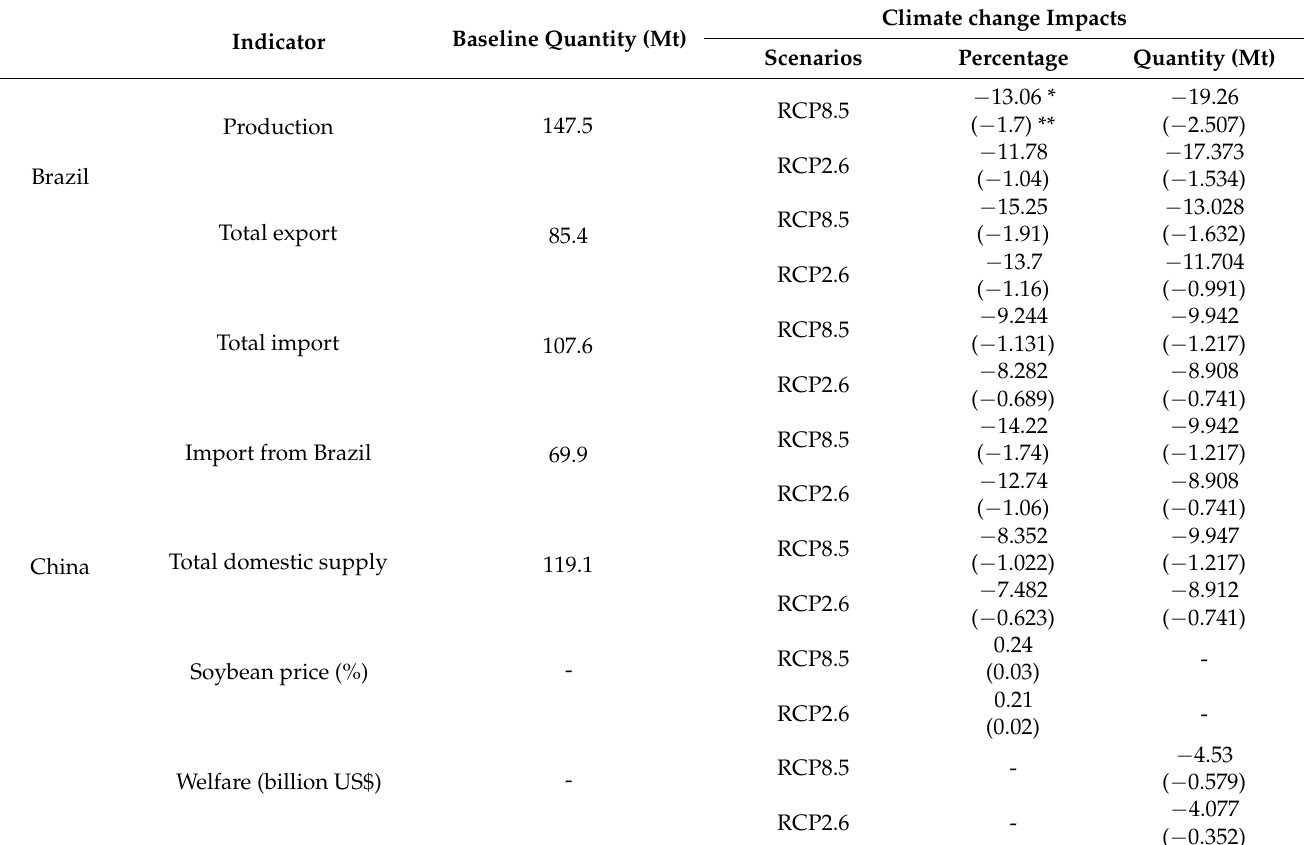
Table 2. Impacts of climate change on Brazil’s soybean production and China’s food security in